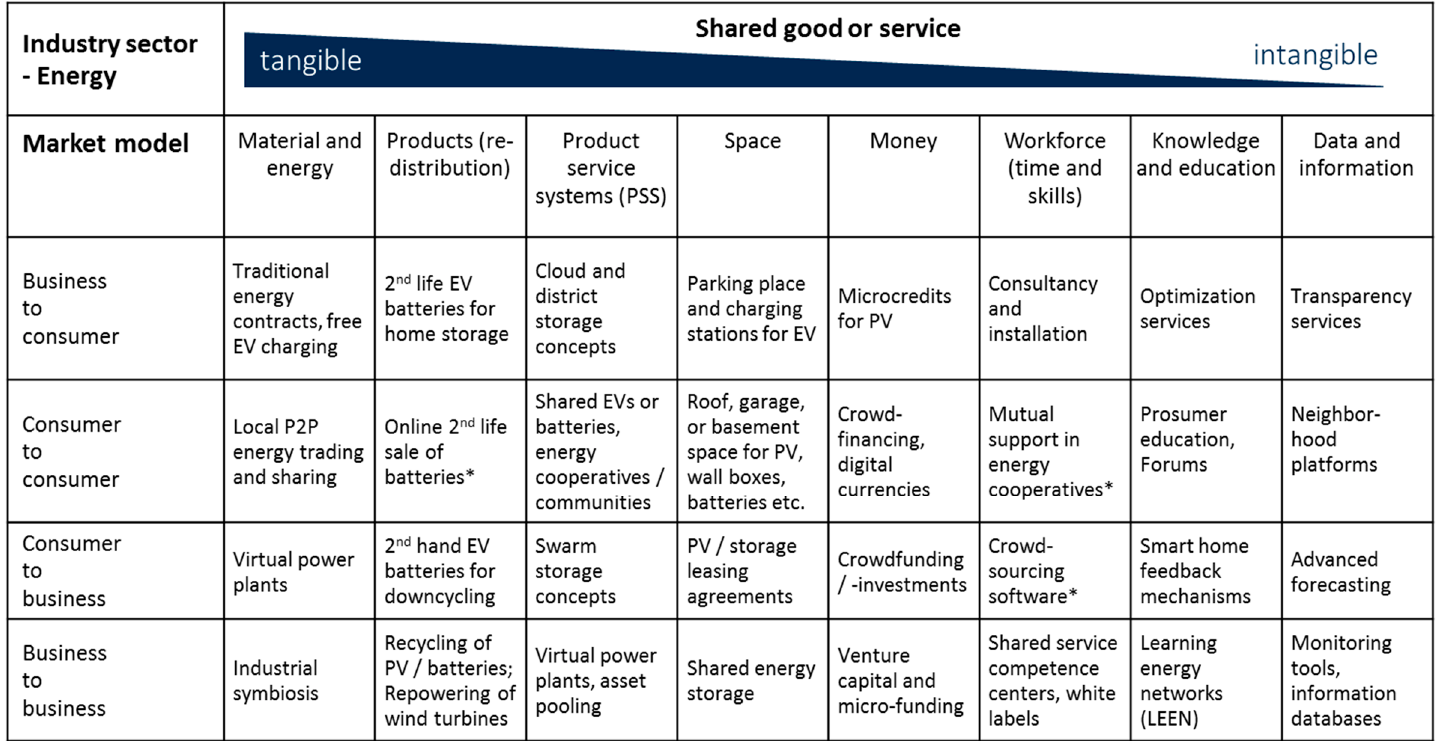
Figure 2. Overview of sharing activities in the energy sector (adapted from Reference [32]). EV = electric vehicles; P2P = peer-to-peer; PV = photovoltaic. Business models indicated with an asterisk (*) are still at the idea stage and no specific implementation of this sharing activity was found.